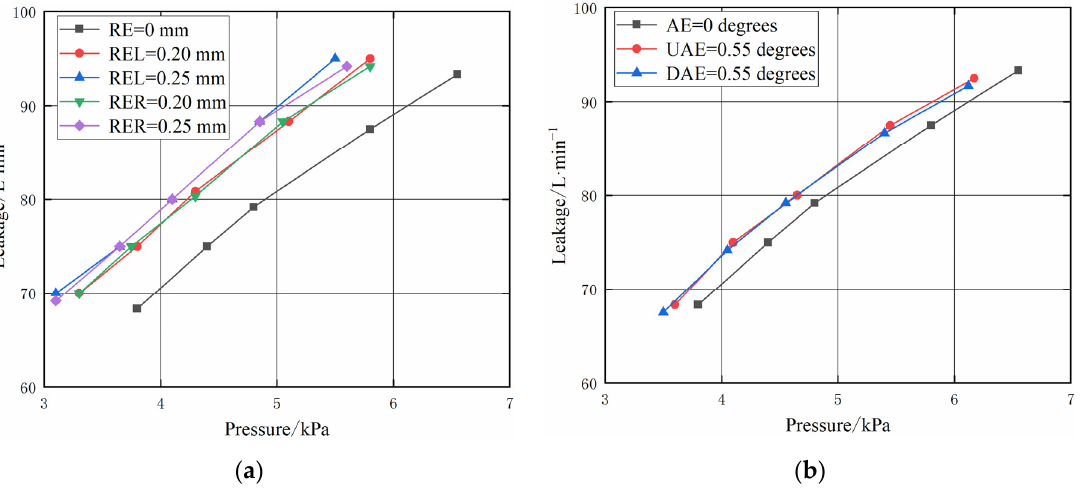
Figure 16. Leakage of labyrinth seal under different eccentricities. ( a ) Radial eccentricity; ( b ) angular eccentricity.